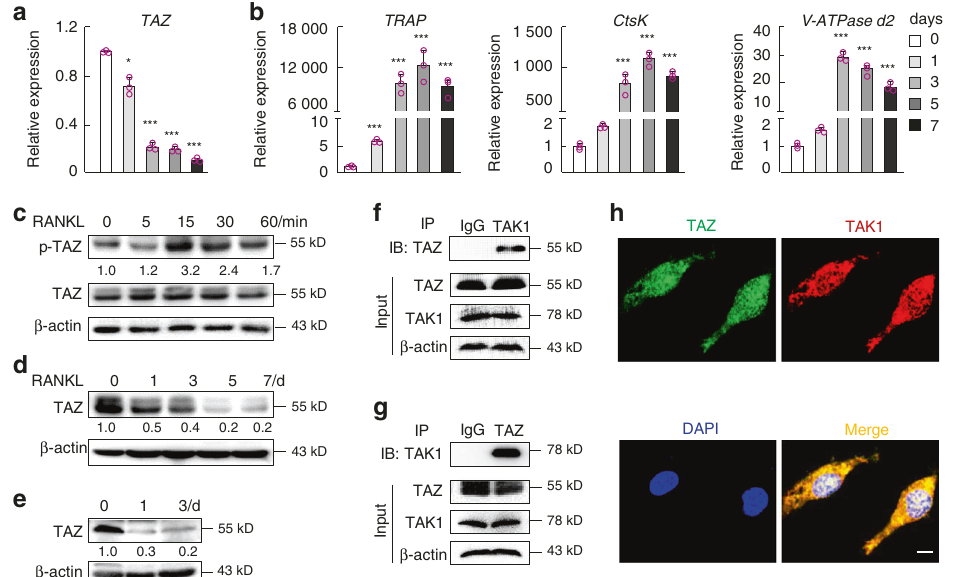
Fig. 5 TAZ interacts with TAK1. Real-time qPCR analysis of the expression of ( a ) TAZ and ( b ) osteoclast marker genes in BMMs stimulated with RANKL for 1, 3, 5, and 7 d. Unstimulated BMMs were used as a mock control. c Western blot analysis of the phosphorylation status of TAZ in BMMs following stimulation with RANKL for 5, 15, 30, and 60 min. Unstimulated BMMs were used as a mock basal control. d Protein expression of TAZ in BMMs stimulated with RANKL for 1, 3, 5, and 7 d and e RAW264.7 cells stimulated with RANKL for 1 and 3 d. Unstimulated cells were used as a mock control. f , g Coimmunoprecipitation analysis of TAZ and TAK1 protein interactions. h Colocalization between TAZ and TAK1 in BMMs by confocal microscopy. Scale bar denotes 5 μ m. n = 3. One-way ANOVA was followed by a post hoc Tukey test. * P < 0.05, ** P < 0.01, and *** P < 0.001. BMMs, bone marrow-derived TAZ interacts with TAK1 during RANKL-induced osteoclast differentiation